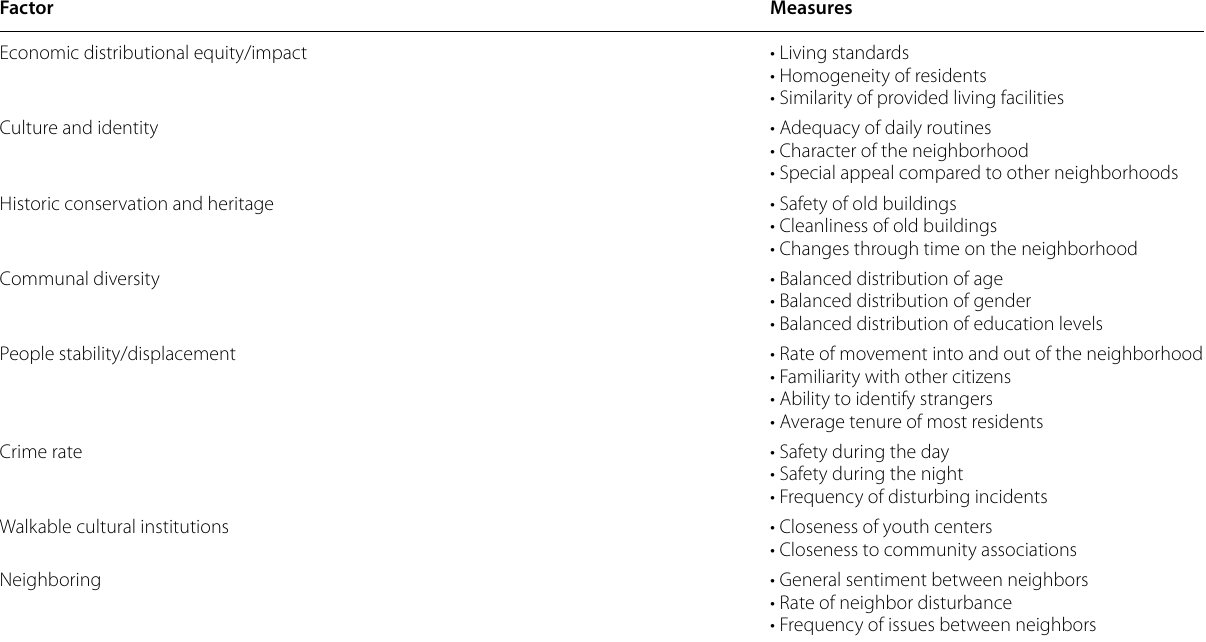
Table 9 Measures of sample factors utilised in the residents’ questionnaire